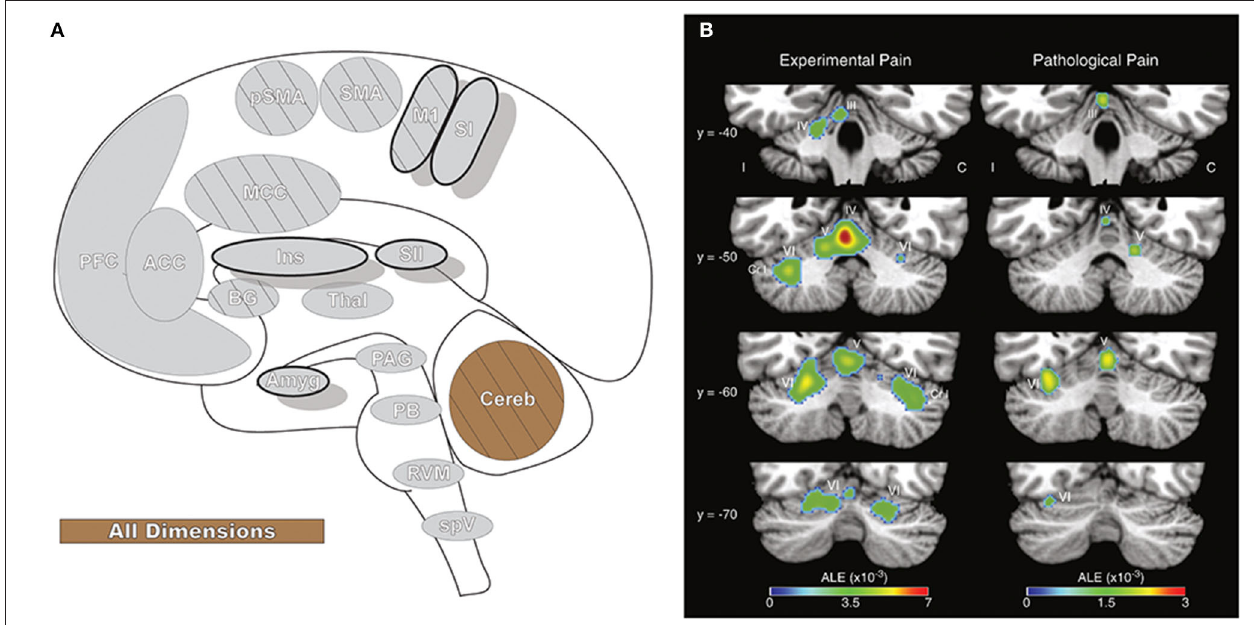
FIGURE 11 | Cerebellum. (A) Brain areas active during pain: cerebellum (Cereb) highlighted. (B) Cerebellar activation likelihood estimation (ALE), derived from meta-analysis of 56 experimental and 20 pathological pain studies, illustrates that fMRI activity is frequently present in specific cerebellar foci during pain. Reprinted from Brain Research Reviews, Vol 65(1), EA Moulton, JD Schmahmann, L Becerra, D Borsook, The cerebellum and pain: Passive integrator or active participator?, p14–27, Copyright (2010), with permission from Elsevier. DOI: https://doi.org/10.1016/j.brainresrev.2010.05.005. C, activation contralateral to painful stimuli; I, activation ipsilateral to painful stimuli; Cr I, Crus I; III-VI, cerebellar hemispheric lobules III through